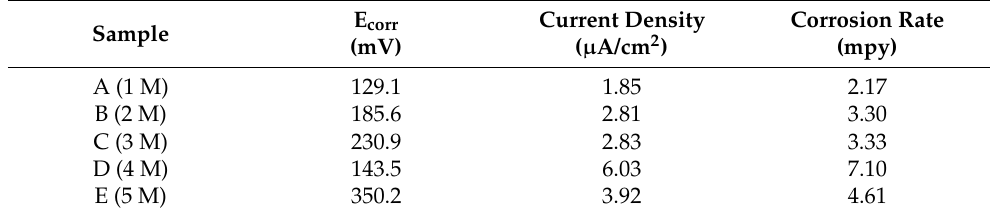
Table 1. E corr , current density, and corrosion rate at 6 V and variations in sulfuric acid concentration. Sample